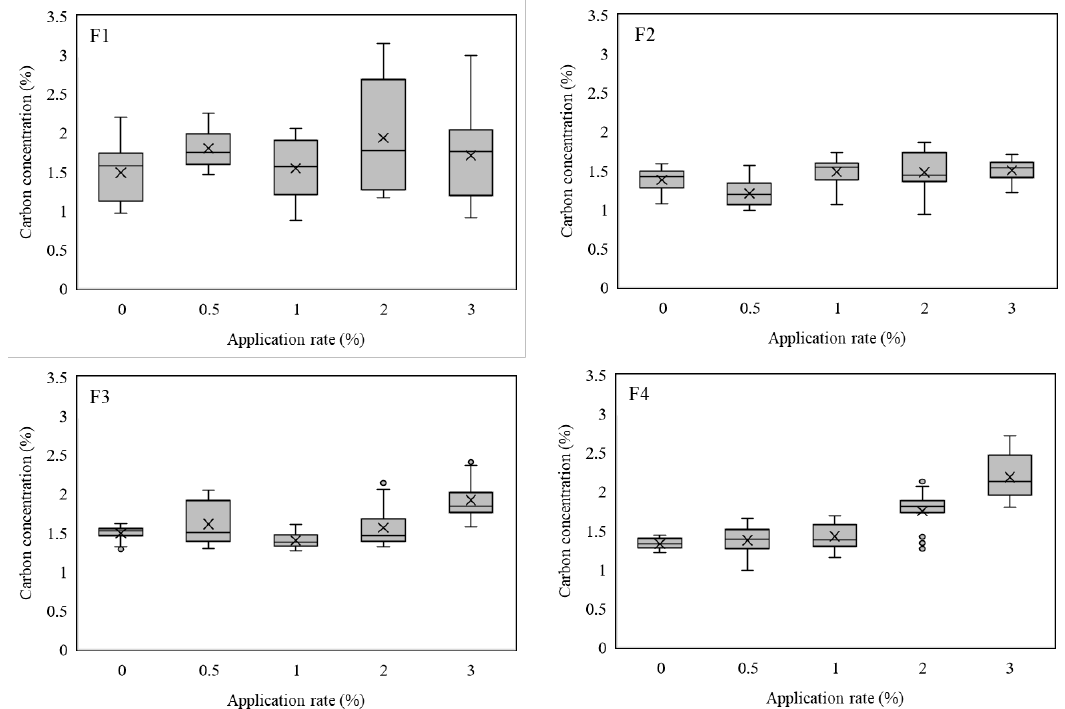
Figure 1. Box plot graph showing the soil carbon content with different application rate in F1, F2, F3, and F4. (F1: CBB ash A and pig manure; F2: CBB ash A; F3: CBB ash B and pig manure; F4: CBB ash